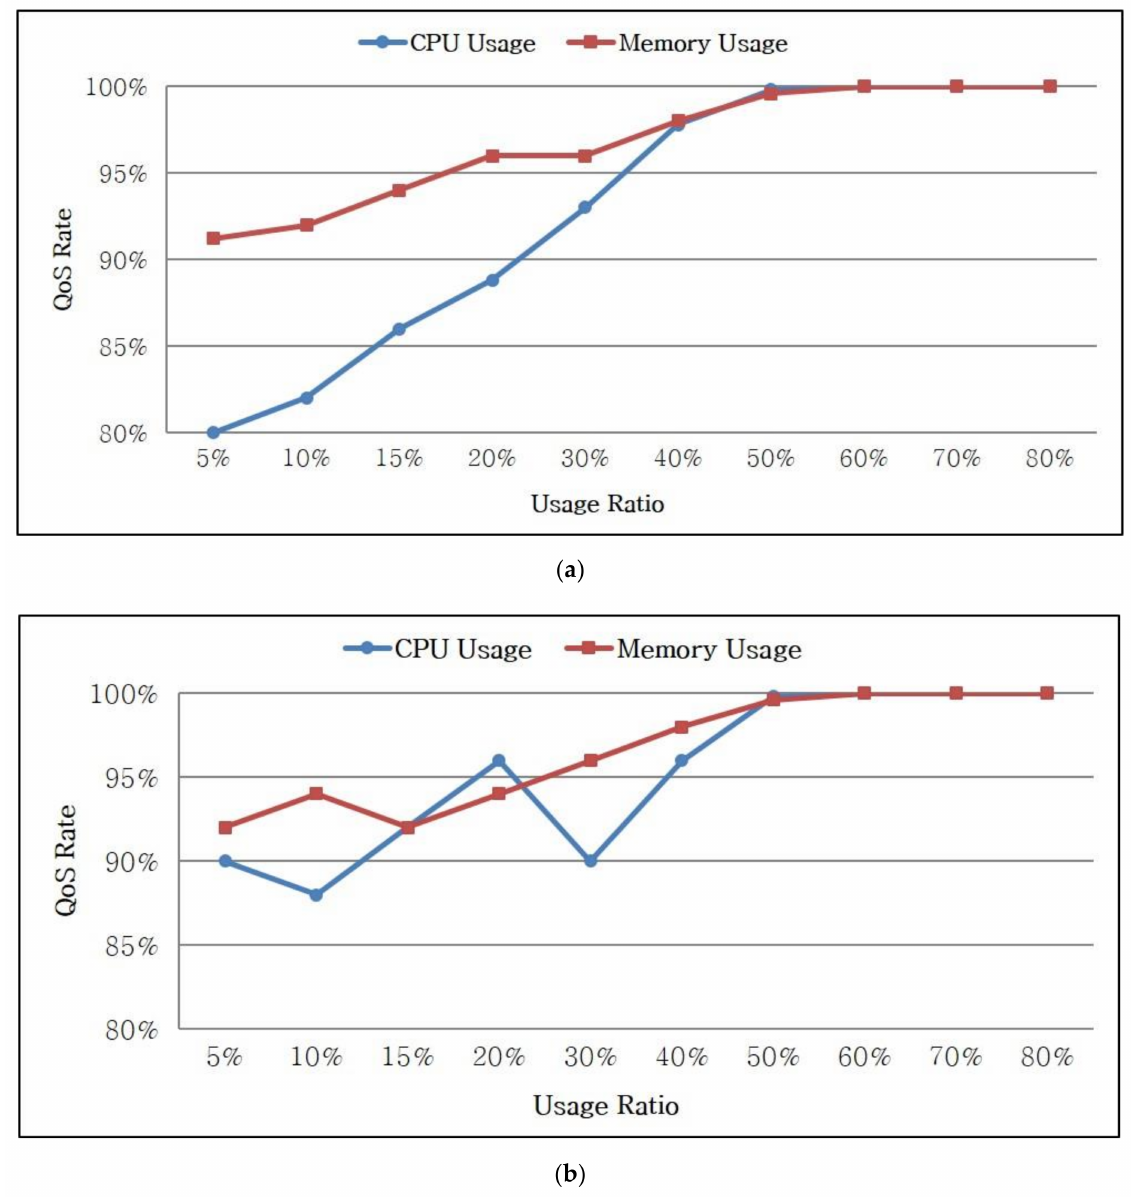
Figure 8. QoS rates based on resource usage. ( a ) QoS rate for simple query; ( b ) QoS rate for complex